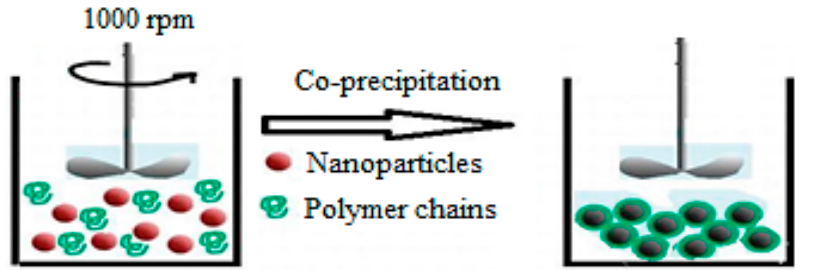
Figure 2. Schematic illustration for the solution mixing method (taken from [27]).